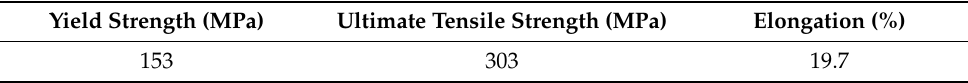
Table 2. Tensile properties along the RD of the AZ31B Mg alloy sheet. Yield Strength